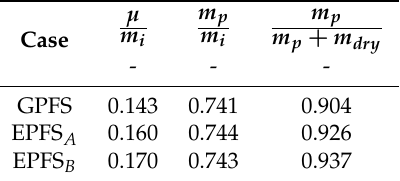
Table 7. Mass budget comparison: normalized